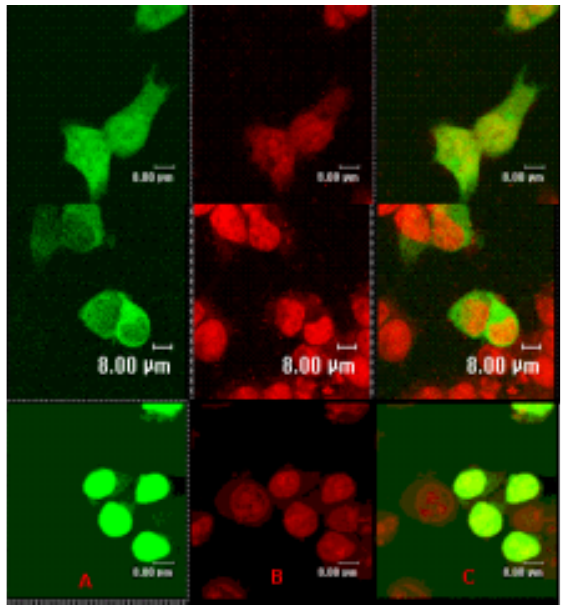
Fig. 1. A. EGFP,EGFP-11E6 and EGFP-16E;. B. PI;